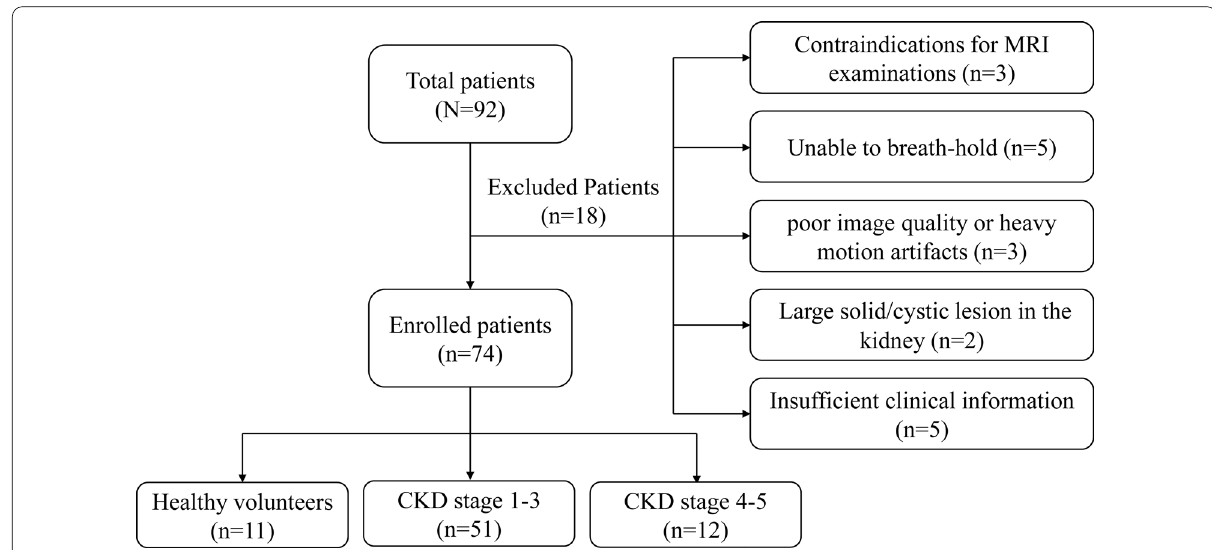
Fig. 1 Flowchart of the study population